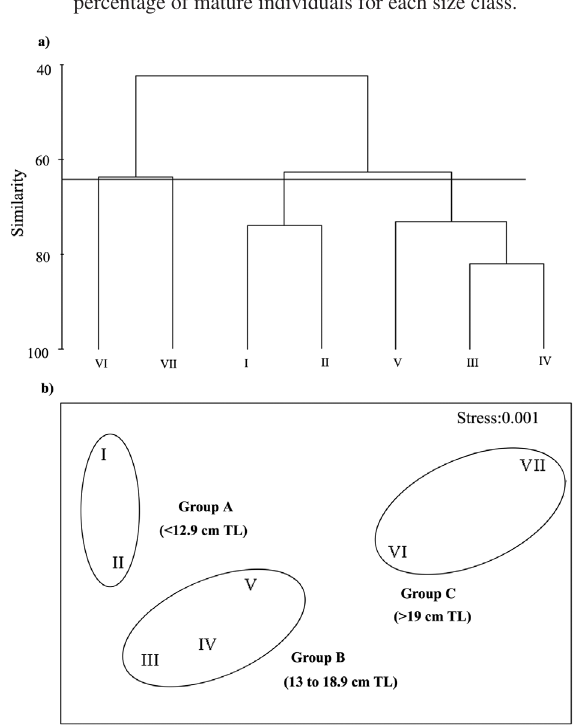
Fig . 3. – Dendogram (a) and NMDS plot (b) based on the IRI% values, using group-average clustering from Bray-Curtis similarity on diet